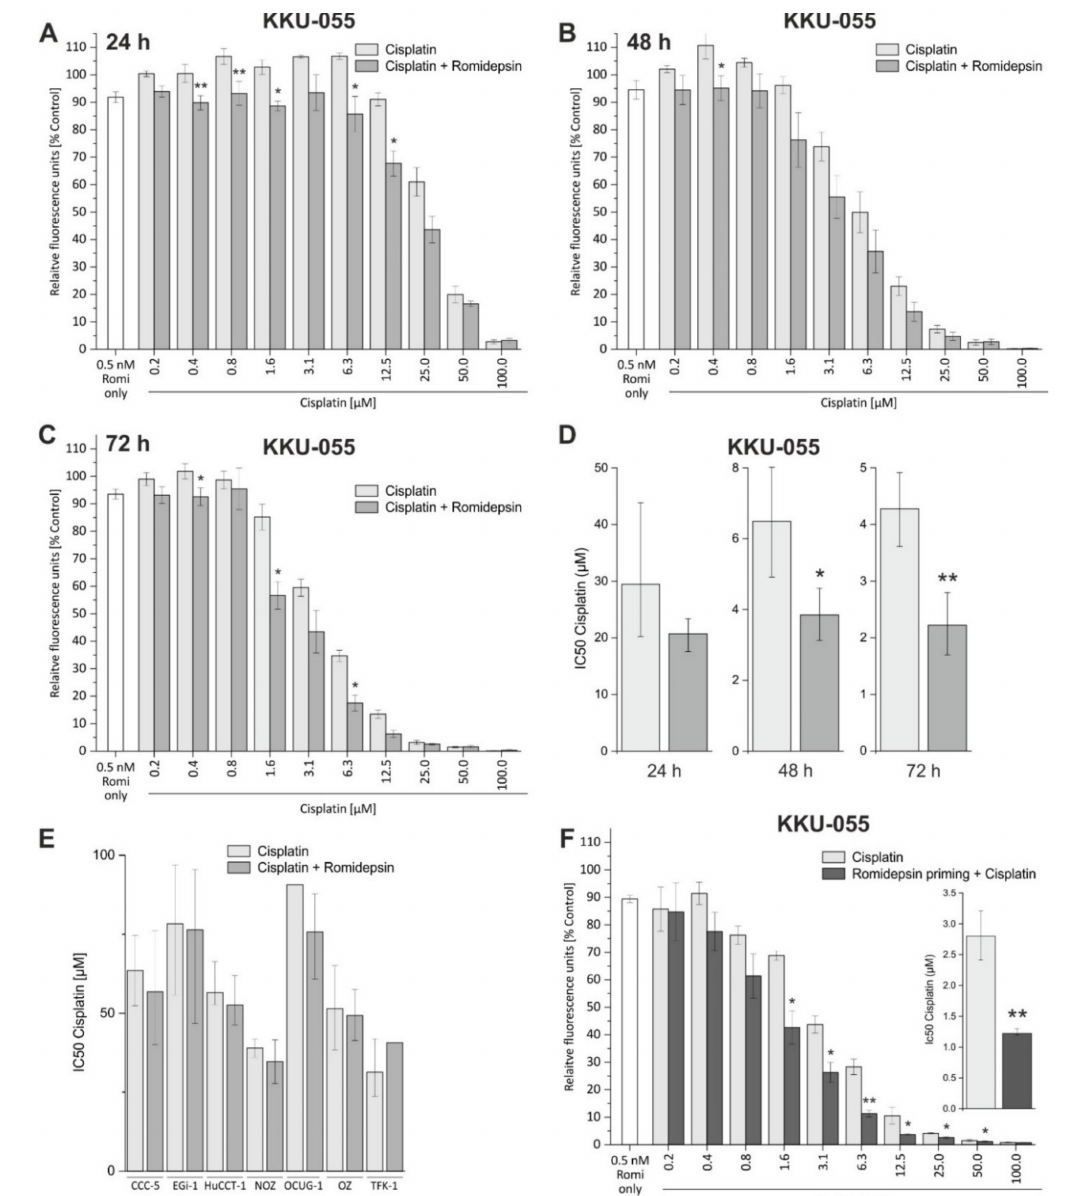
Figure 6. Romidepsin augments the cytotoxic effect of cisplatin in KKU-055 cells. ( A – C ) Simultaneous treatment of KKU-055 cells with a dilution series of cisplatin and 0.5 nM romidepsin for 24 h ( A ), 48 h ( B ), and 72 h ( C ), respectively, augments the cytotoxic effect of single cisplatin treatment for specific cisplatin concentrations. The left bar (white) represents the cytotoxic effect of 0.5 nM romidepsin as a single treatment. ( D ) Comparison of IC 50 values between cisplatin-only and combined romidepsin and cisplatin treatment for KKU-055 cells (error bars indicate the 95% confidence interval). ( E ) IC 50 values for cisplatin-only and combined simultaneous cisplatin romidepsin treatment for remaining BTC cells after 72 h treatment (error bars indicate the 95% confidence interval) ( F ). Pre-incubation of KKU-055 cells for 48 h with 0.5 nM romidepsin (priming) before the addition of cisplatin (dilution series). The respective IC 50 values are shown in the insert (error bars indicate the 95% confidence interval). Data are presented as mean value ± SEM of n = 3 (KKU-055 cells) or n = 4 individual biological replicates. Asterisks indicate significant (* p < 0.05) or highly significant (** p < 0.01) differences. Abbreviations: BTC, biliary tract